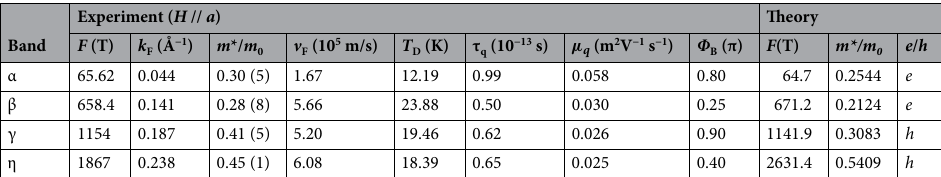
Table 1. Parameters obtained from the dHvA oscillations for H // a including the oscillation frequency ( F ), the Fermi wave vector ( k F ), the effective mass ( m* ), the Fermi velocity ( v F ), the Dingle temperature ( T D ), the quantum relaxation time (τ q ), and the quantum mobility ( µ q ) . The calculated dHvA frequency ( F ), effective mass ( m *) and carrier type (electron(e)/hole(h)) character are also listed.